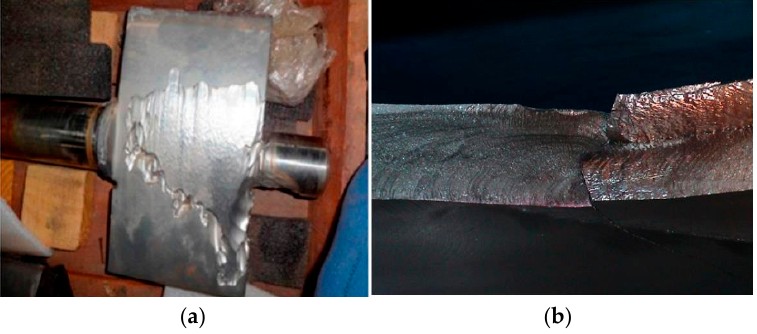
Figure 27. Damage of machinery due to pressure fluctuation: ( a ) Wearing plate erosion in Francis Turbine [63]; ( b ) crack on the runner with beach marks [64]. Turbine [63]; ( b ) crack on the runner with beach marks